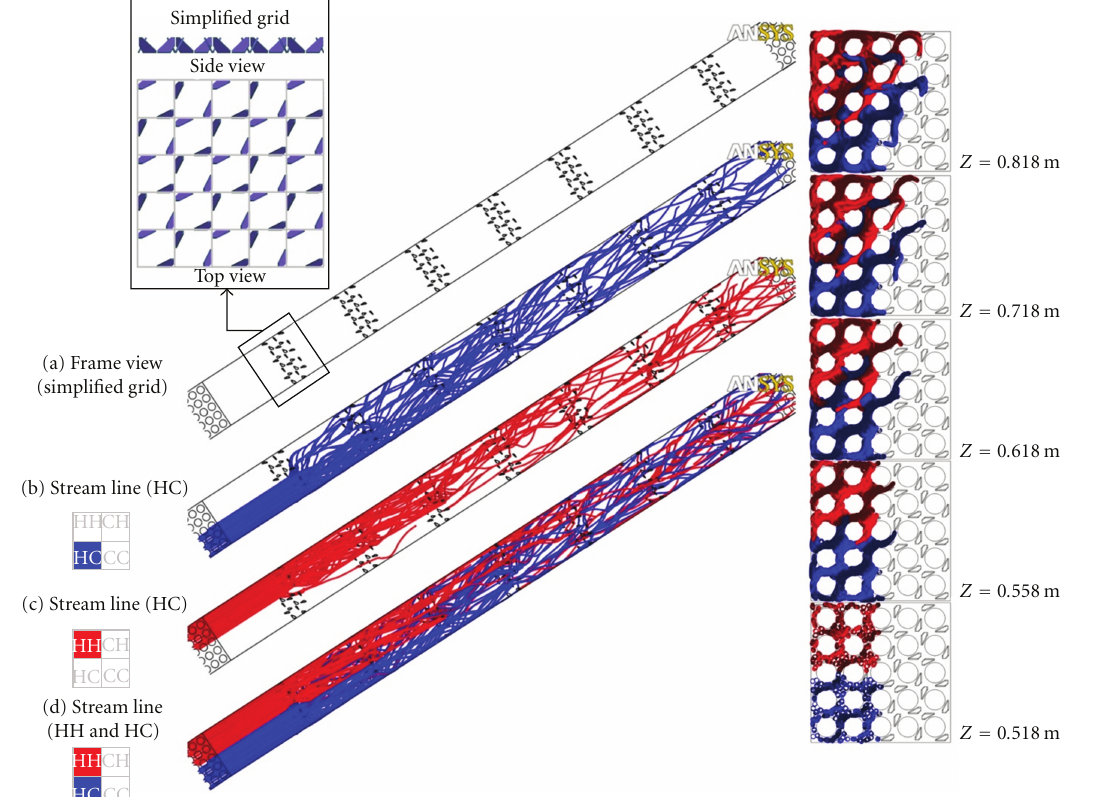
Figure 7: Modelling and results of CFD analysis for Test number 01-5237.